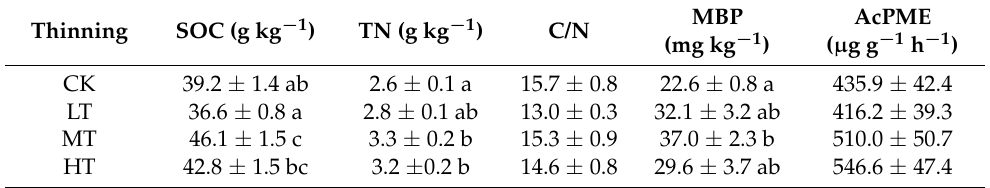
Table 2. Soil physical and chemical properties in studied sites under four thinning treatments in 2017.